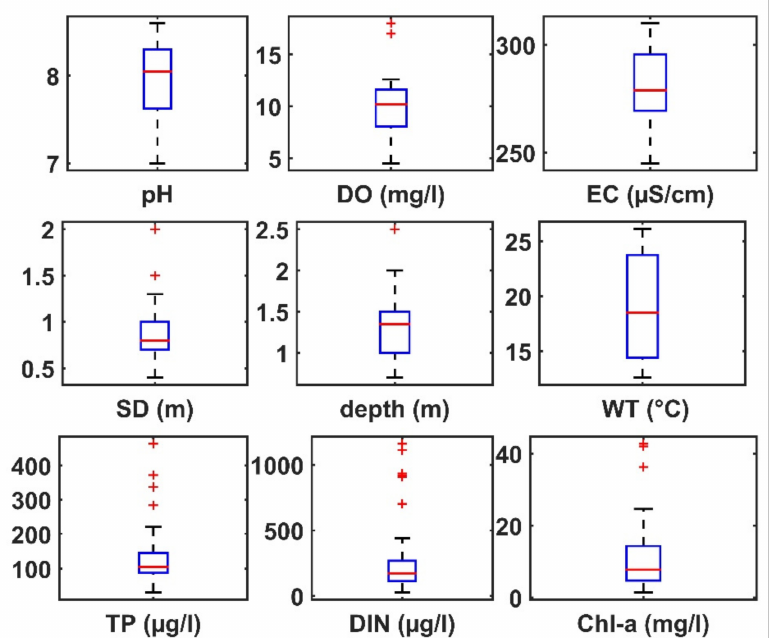
Figure 2. Box plot of the monitored environmental parameters (red horizontal line: median value; box: 25–75% percentile; whiskers: valid range; red marks: extreme values referred as